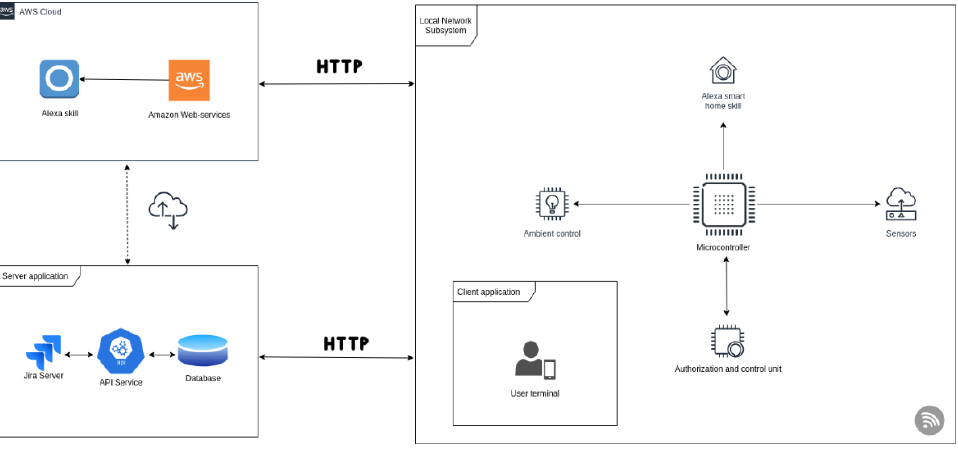
Figure 3. System architecture.